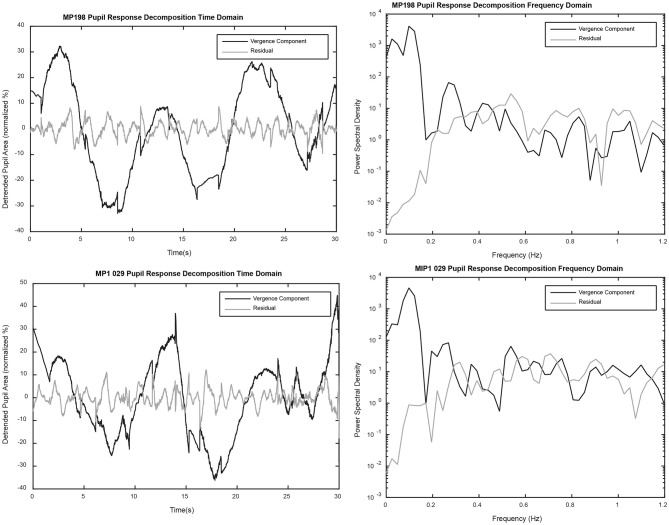
The left panels show a decomposition of the detrended pupil data into components predicted by (1) the relationship with detrended vergence eye movements alone (black) and (2) the residual (gray). The power spectral densities for each component (right panels) were calculated with the “periodogram.m” function in MATLAB (MathWorks, Inc., Natick, MA), using a full length Hamming window and a 4,096 point fast Fourier transform.